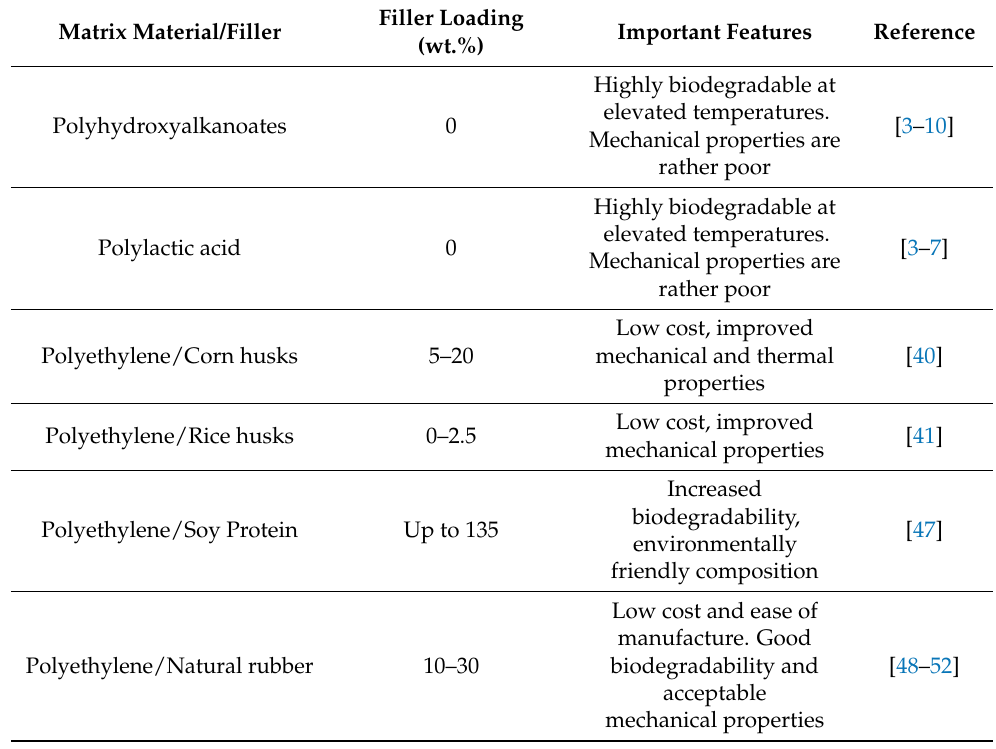
Table 1. Summary of biodegradable polymer composites with natural fillers. Matrix